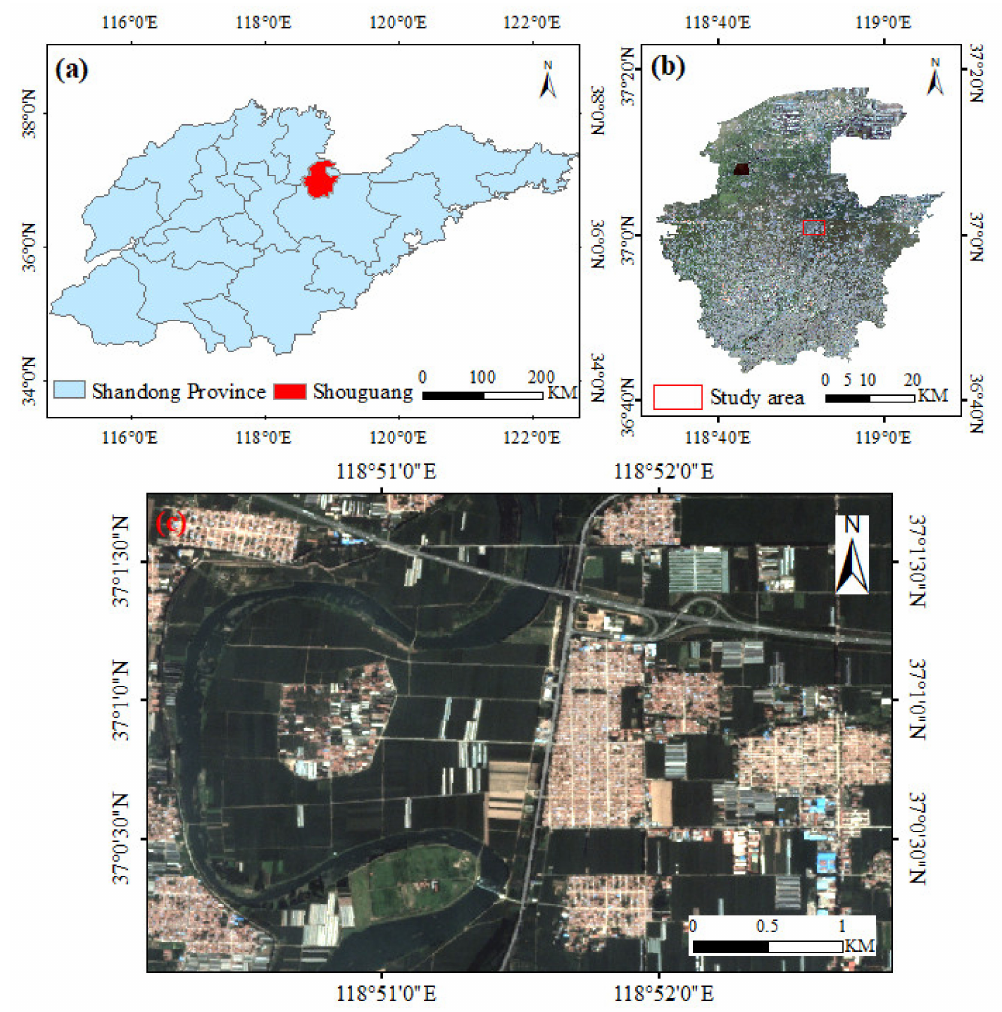
Figure 1. Map of the study area: ( a ) Municipal administrative boundary of Shandong Province; ( b ) Sentinel-2 RGB composite image of study area of Shouguang City; ( c ) Planet RGB composite image of the study